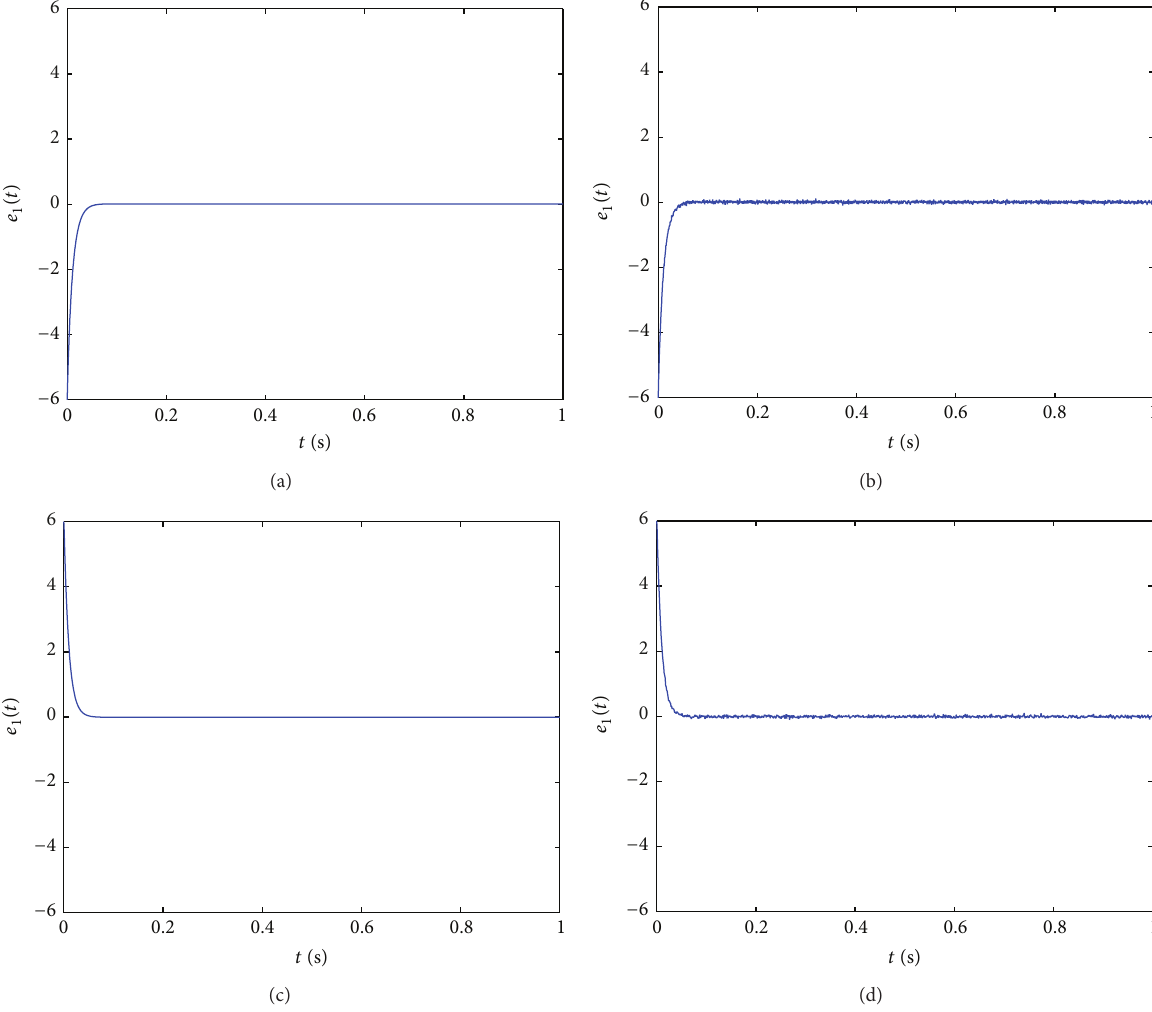
Figure 10: Comparison of the time waveforms of synchronization errors 𝑒 1 (𝑡) without and with noise, panels (a)-(b) and (c)-(d) show the results of the hyperchaotic Chen system and Lorenz system,